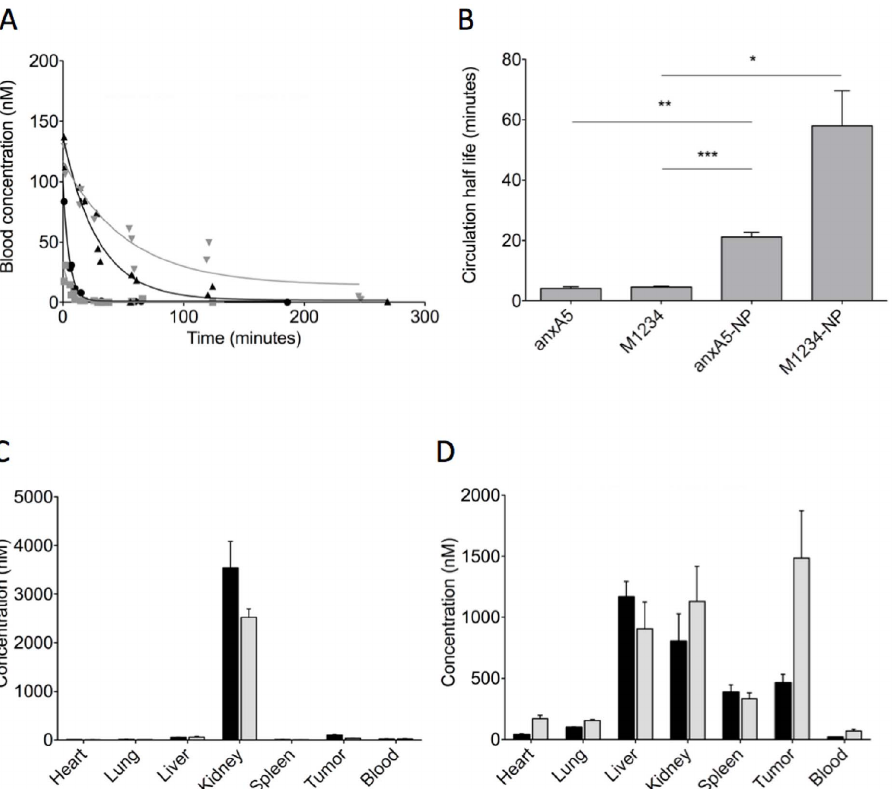
Figure 5. Blood clearance and biodistribution of annexin-variants in NMRI nude mice. 2 nmoles of fluorescently-labeled annexin-variant were injected intravenously. At various time-points 25 m l blood samples were collected to measure fluorescence. Blood concentration of annexin- variant was calculated using the constructed reference curves. Panel A shows the blood clearance of anxA5 (grey squares), M1234 (black circles), anxA5-NP (black triangles) and M1234-NP (grey triangles). Half-lives were calculated by mono-exponential fit (B). *p , 0.05, **p , 0.01, ***p , 0.001. 2 nmoles of fluorescently labeled anxA5 (black bars, panel C), M1234 (grey bars, panel C), anxA5-NP (black bars, panel D) and M1234-NP (grey bars, panel D) were injected intravenously into tumor-bearing NMRI nude mice. 1 hour (panel C) and 24 hours (panel D) post-injection organs were collected, weighed and measured for fluorescence. Concentration of annexin-variant were calculated using the constructed reference curves.